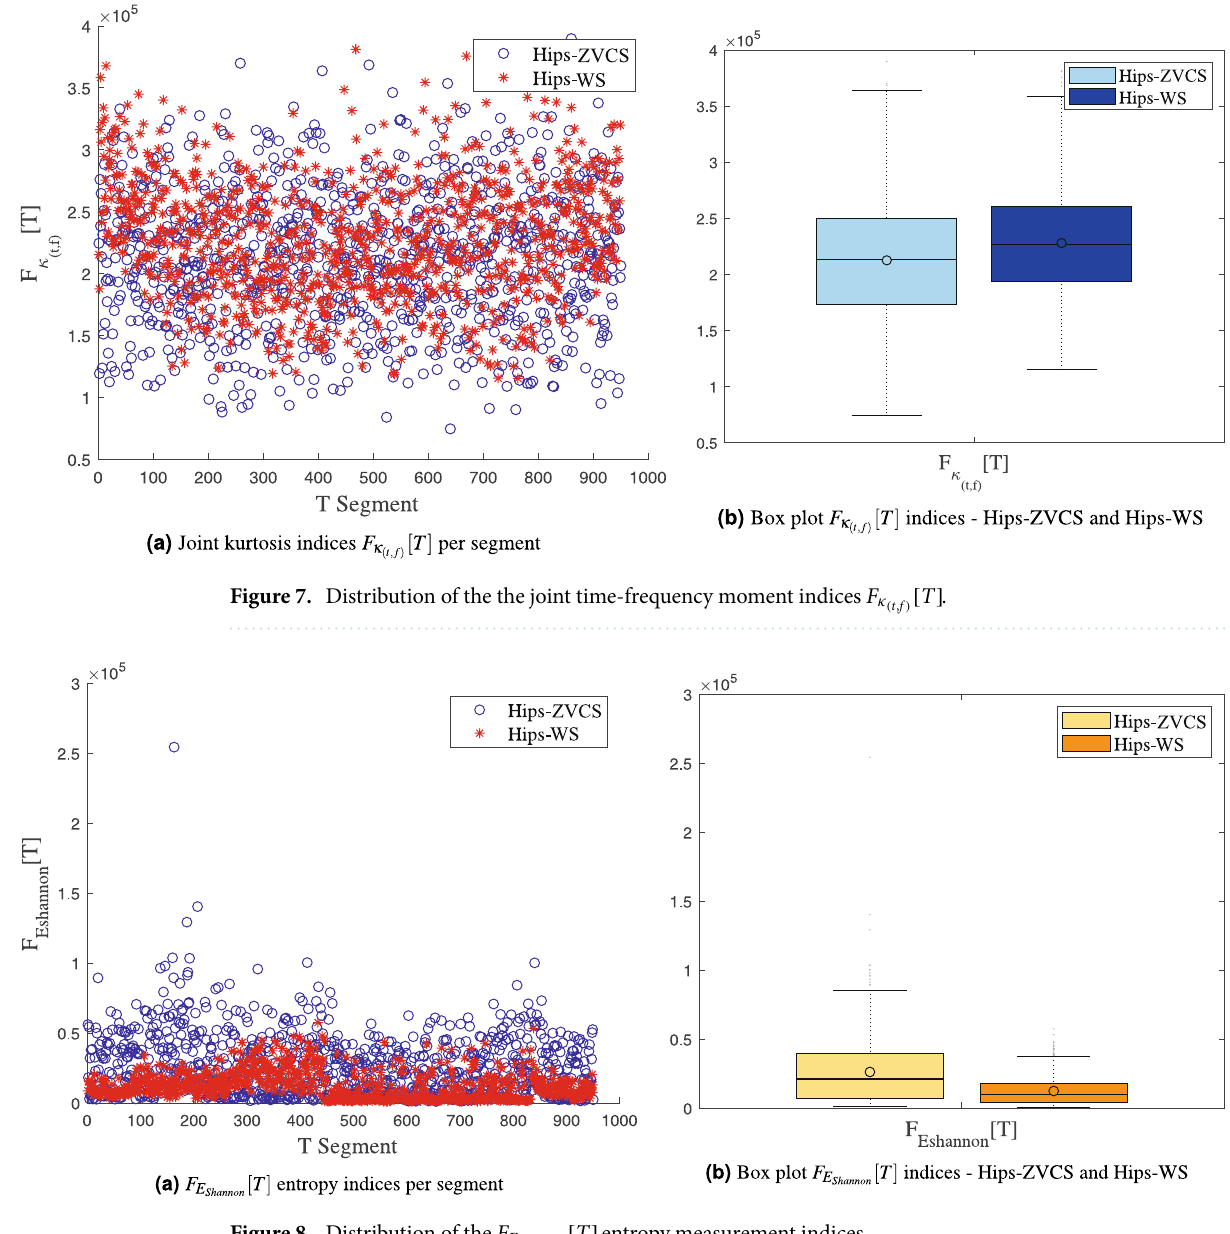
Figure 8. Distribution of the F E